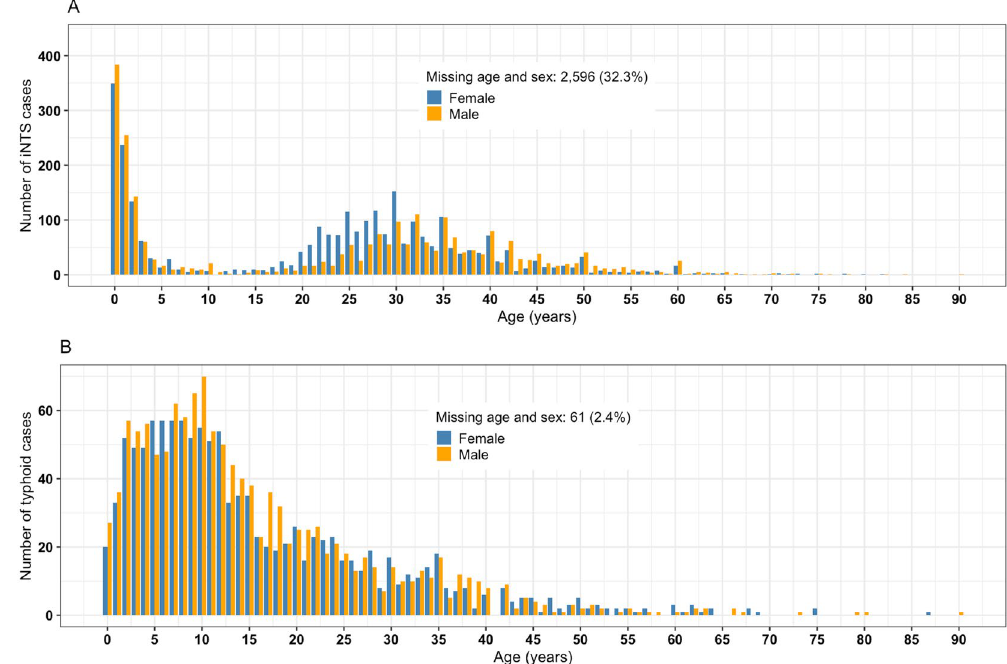
Figure 3. Age and sex distribution of invasive Salmonella cases. Nontyphoid (iNTS) ( A ) and typhoid ( B ) cases confirmed by blood culture at the Malawi Liverpool Wellcome Trust Clinical Programme in Blantyre, Malawi over the yearly period from 2000 to